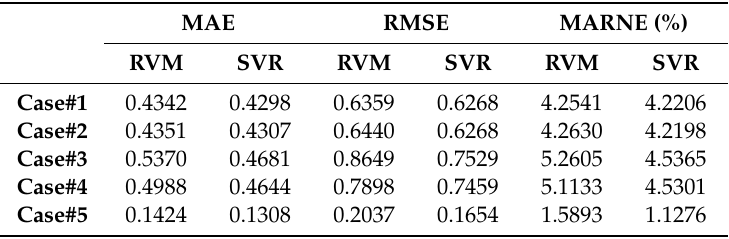
Table 6. Evaluation of RVM and SVR considering the 10-min-ahead